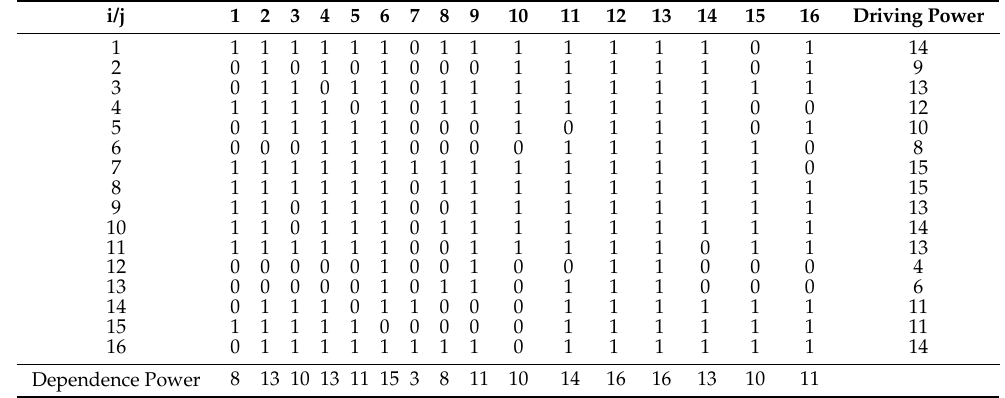
Table 5. Final Reachability